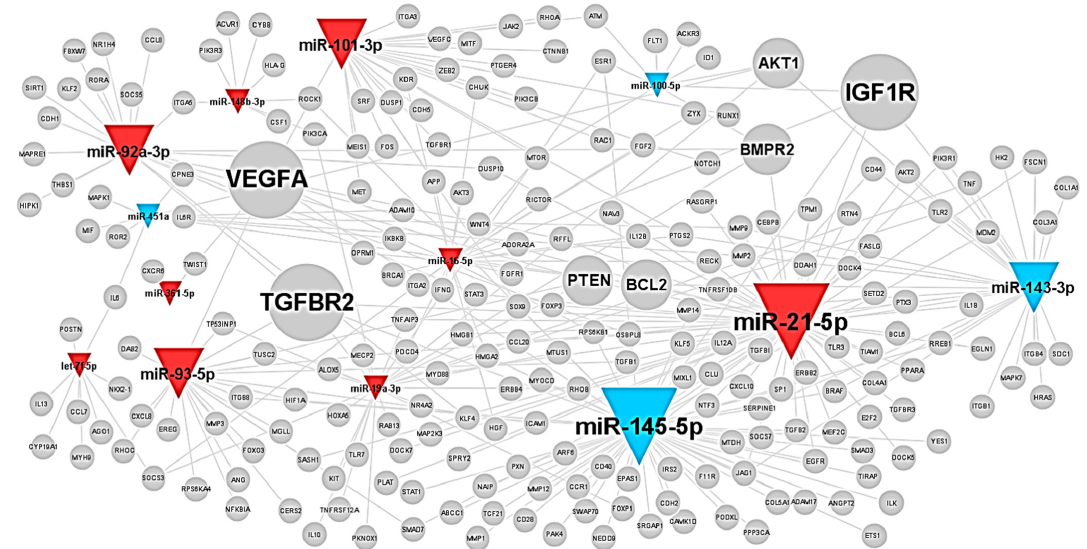
Figure A5. The typical miRNAs–target network in shear stress-induced EC-sEVs was visualized by WEB-based Gene SeT AnaLysis Toolkit (WebGestalt). The colors of triangles indicate upregulated (red) or downregulated (blue) miRNAs in OSS-sEVs compared to LSS-sEVs. The size of the gray nodes representing target proteins indicates the number of miRNAs regulating the target